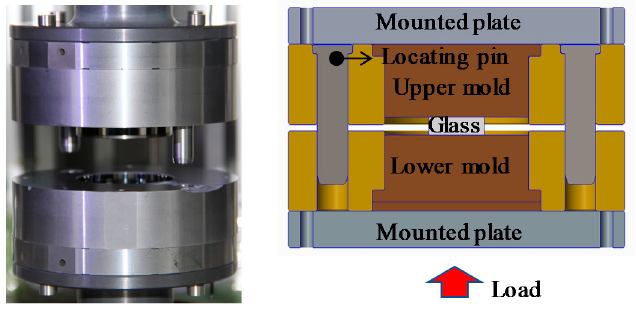
Figure 6. Setup of glass molding.